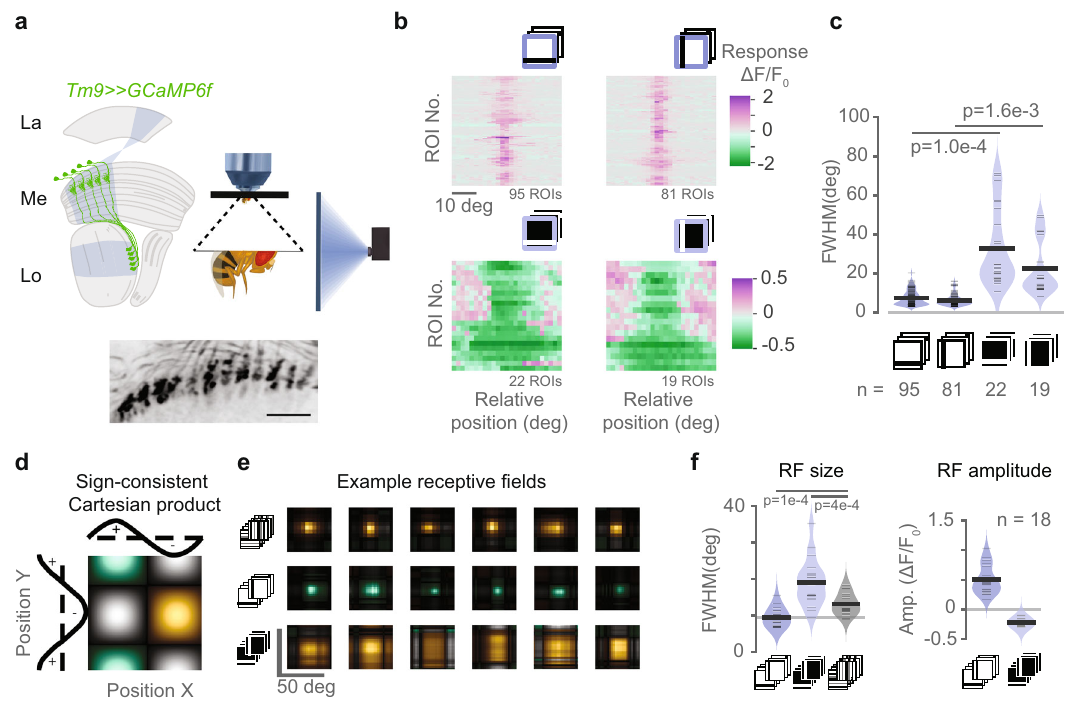
Fig. 2 Tm9 has wide ON and narrow OFF receptive fi elds. a Schematic showing the experimental setup used for in vivo two-photon calcium imaging of Tm9 neurons expressing GCaMP6f under visual stimulation. Visual information (blue) passes from the lamina (La) through the medulla (Me) housing Tm9 neurons into the lobula (Lo), where we recorded from Tm9 axon terminals (example image from a recording shown at the bottom, 1 from 14 fl ies). Scale bar = 10 μ m. b Receptive fi elds obtained from Tm9 responses to ON (blue) and OFF bars (light blue) in horizontal and vertical orientations. Receptive fi eld centers are aligned for illustrative purposes. For each stimulus, only neurons with responses fi tted by a single Gaussian with r 2 > 0.2 and response quality index above 0.5 were included. c Full width at half maximum (FWHM) of a single Gaussian fi tted to the receptive fi elds in b . n = 95, 81, 22, 19 ROIs (regions of interest), from 12, 10, 6, 5 fl ies. d Two-dimensional visualization of spatial receptive fi elds by color-coding the Cartesian product of two orthogonal one-dimensional receptive fi elds (from calcium signal or fi lter amplitude) according to the sign and response strength: positive in both orientations in green, negative in both orientations in yellow, and opposing signs in gray. Color luminance linearly encodes the magnitude of the Cartesian product. e Receptive fi elds obtained with different stimuli for the same neurons: ternary white noise (top), OFF bars (middle), and ON bars (bottom). Panel shows receptive fi elds from six example neurons from six fl ies. f Amplitude and FWHM obtained from fi tting a single Gaussian to each neuron ’ s receptive fi eld in the population ( n = 18 ROIs, from six fl ies). c , f p -values come from two-tailed permutation tests. Source data are provided as a Source Data fi